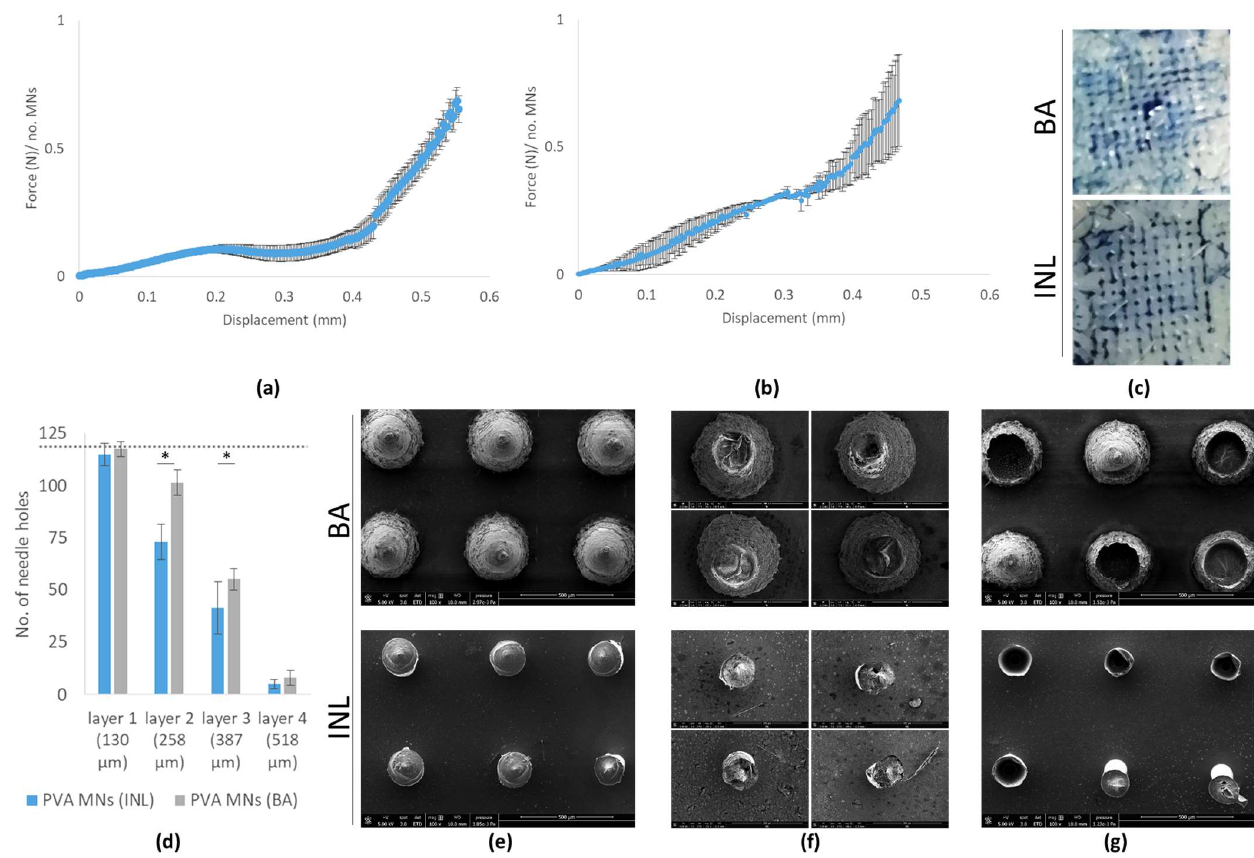
Figure 4. Force-displacement and Parafilm ® M perforation using the PVA MNs fabricated with the different molds. ( a ) force-displacement of the PVA G INL MNs; ( b ) force-displacement of the PVA G BlueAcre (BA) MNs; ( c ) porcine skin perforation test stained with Trypan blue (0.4% v / v ); ( d ) Parafilm ® M perforation test, dashed line corresponds to the maximum of needles in the arrays (121 needles), and the average thickness of the layers was measured with a Schut electronic outside micrometer (0.1–2.5 mm; 0.001 mm), * statistically significant ( p < 0.05); ( e ) SEM micrographs of PVA G MNs (INL and BluAcre) after fabrication, ( f ) SEM micrographs of PVA G MNs (INL and BluAcre) after fabrication force-displacement, ( g ) SEM micrographs of PVA MNs (INL and BluAcre) after Parafilm ® M perforation tests. Ruler in ( e , g ) is 500 µm, and in ( f ) is 300 µm.